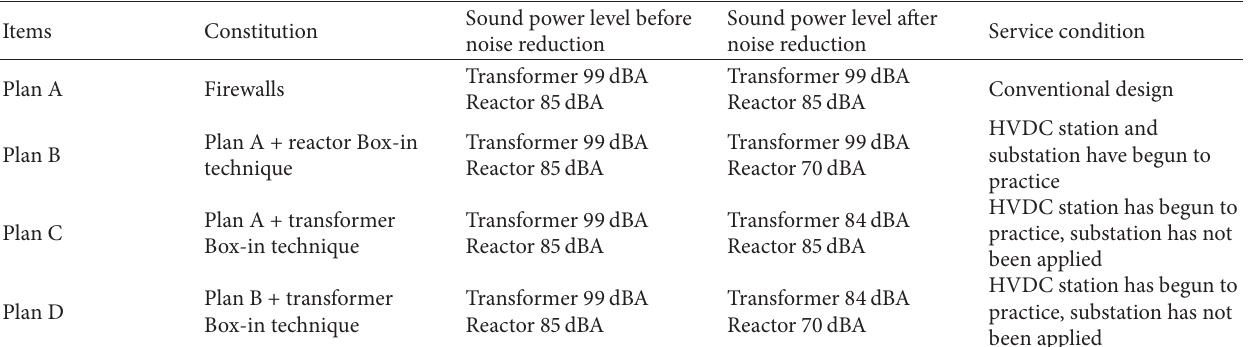
Figure 2: The principal facilities of Lanchow 330 kV substation. 1—330 kV transformer; 2—high voltage reactor; 3—central control building; 4—constructions; 5—noise receiving point. Table 1: Lanchow 330 kV substation noise control plan.